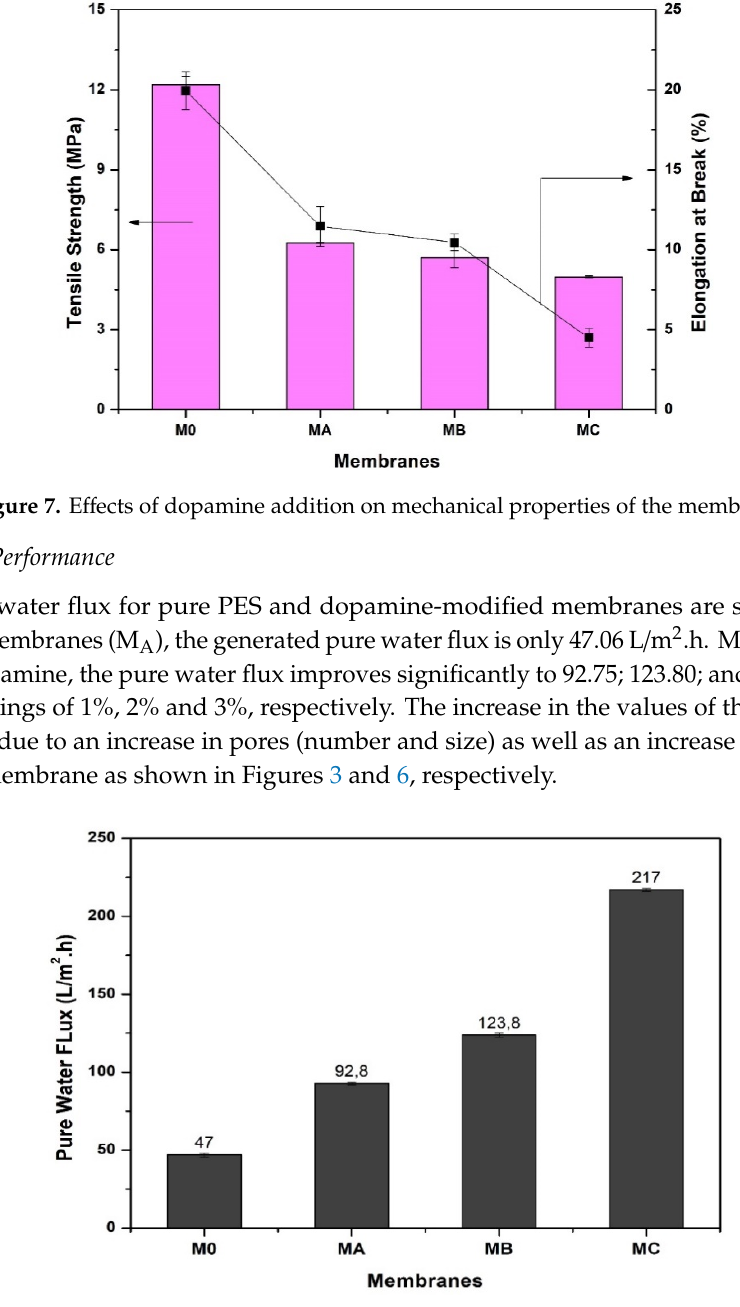
Figure 9. Water permeability and rejection of HA solution.